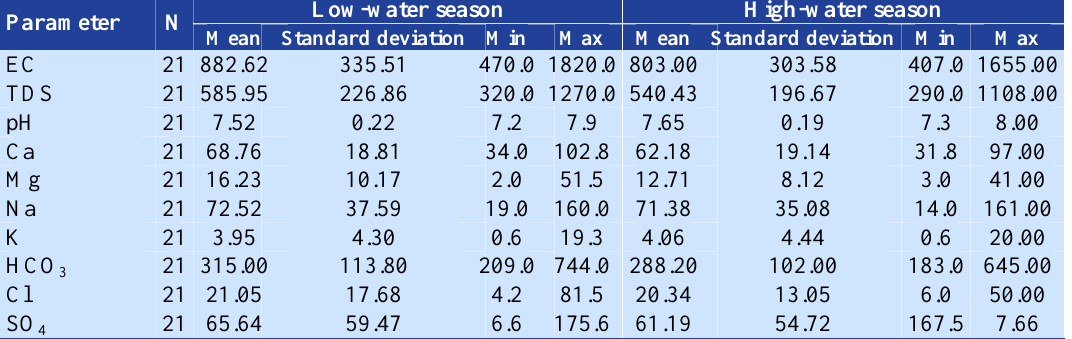
Table 2. Descriptive statistics of elemental concentration for the studied parameters Parameter N